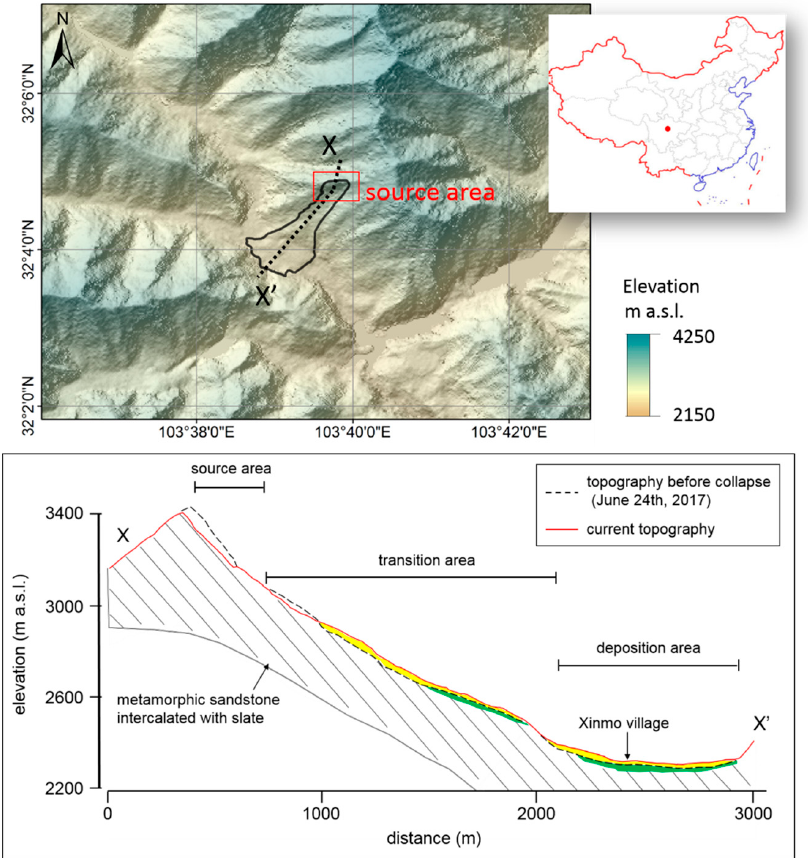
Figure 1. ( Upper ) The digital elevation model (DEM) of the study area, where the black outline represents the affected region. The red rectangle shows the location of the source area. ( Lower ) The geological cross-section of the landslide, in which the yellow represents the deposition caused by the 2017 Xinmo landslide, and the green represents the deposition of an old historical landslide (based on Fan et al. [1] and Dai et al. [15]).